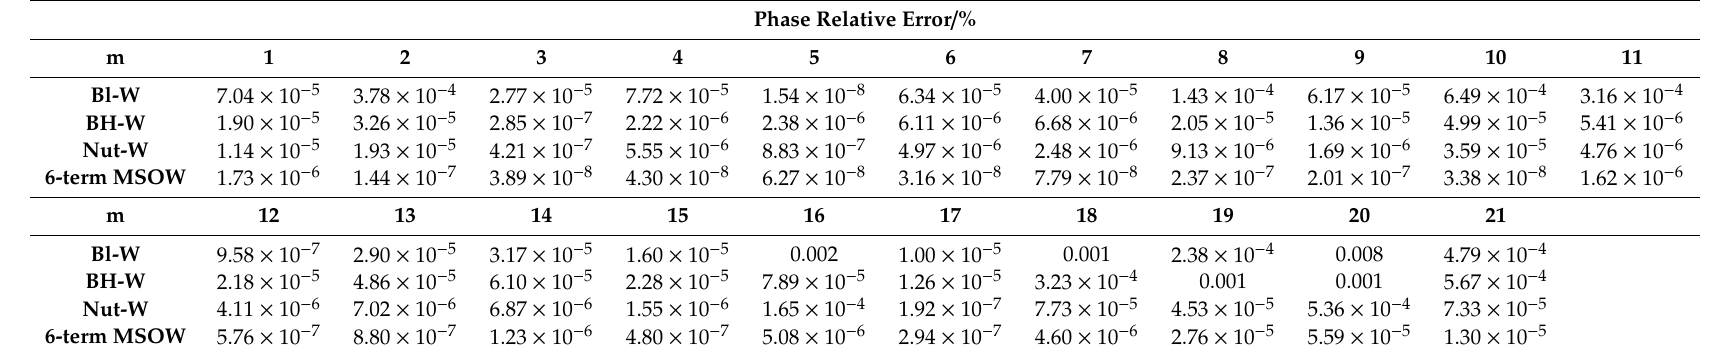
Table 6. Harmonic detection error of phase parameter with high-order and weak-amplitude